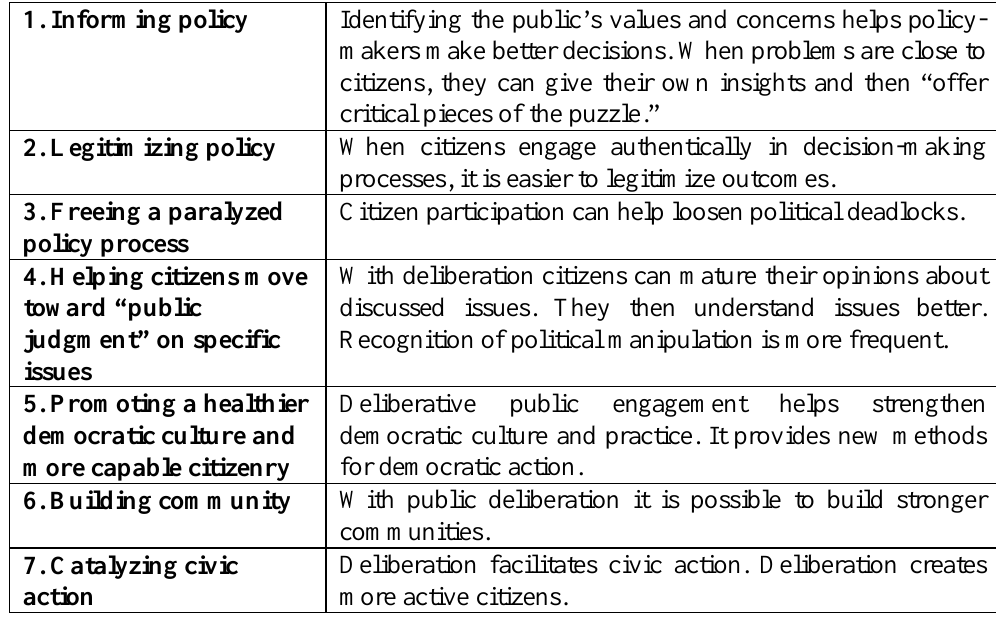
Table 2. Purposes of deliberative public engagement (Friedman 2006: